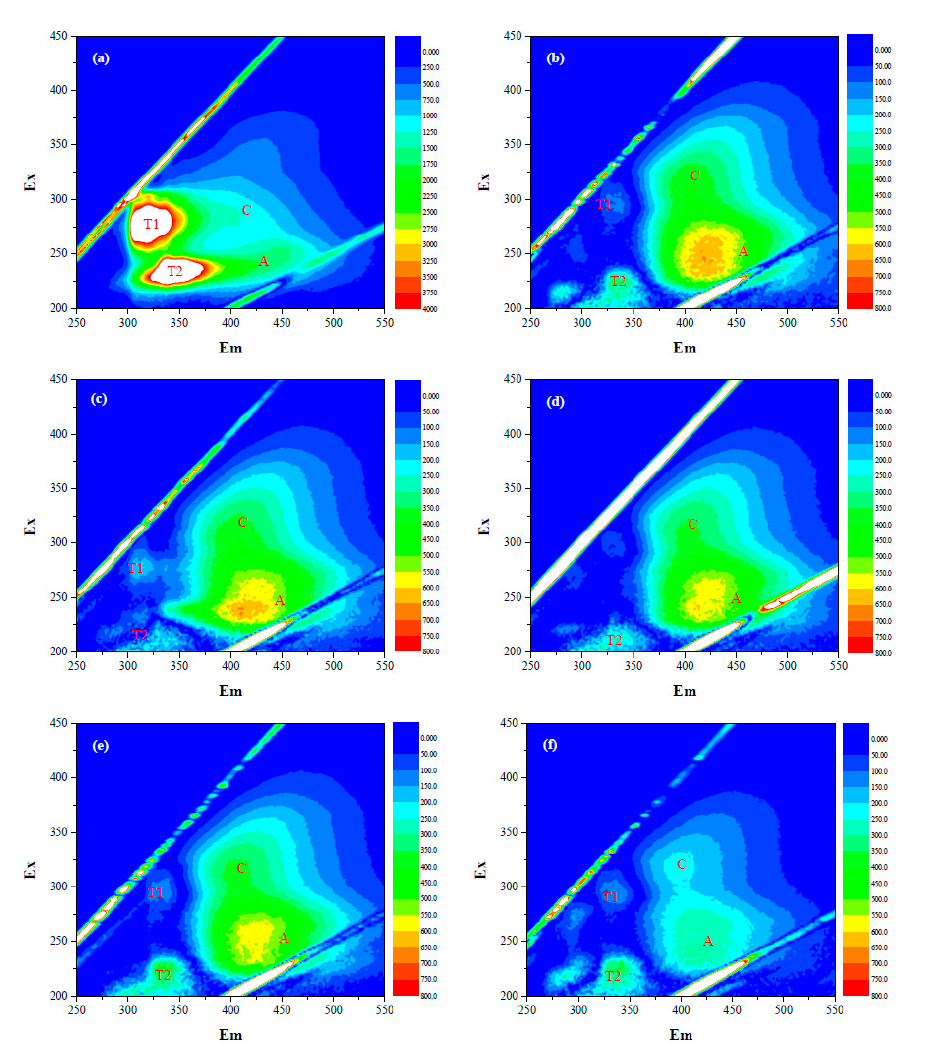
Figure 5. Excitation-emission matrix (EEM) characterization of each step at the 27th day of the experiment: ( a ) raw water without pretreatment, ( b ) after GDM, ( c ) after AS coagulation treatment, ( d ) after AS/GDM, ( e ) after AS-CS coagulation treatment, and ( f ) after AS-CS/GDM.